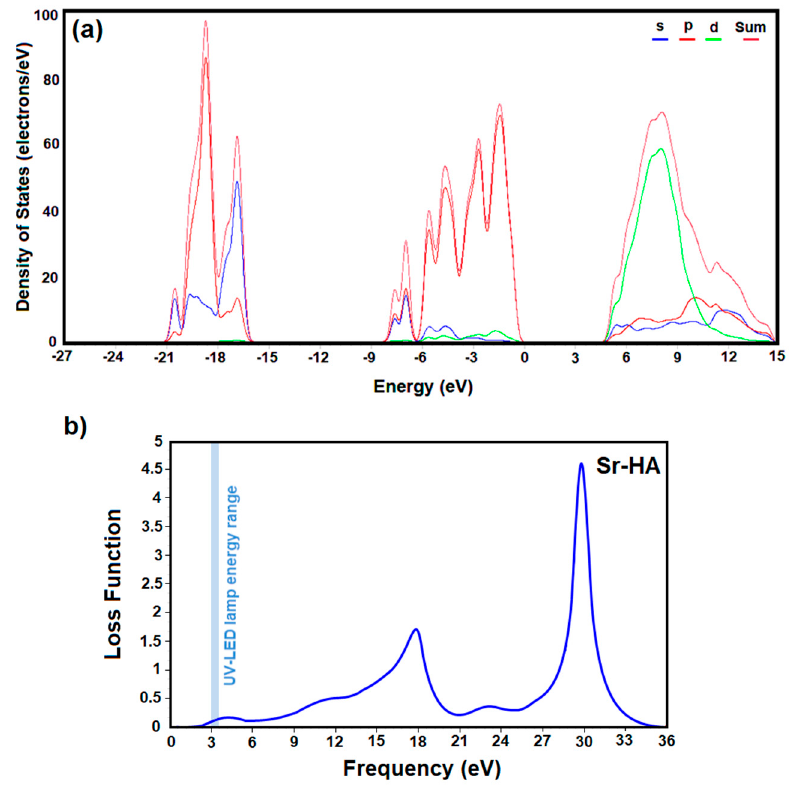
Figure 2. Electronic densities of states ( a ) and energy-loss spectra ( b ) of Sr-doped HA, obtained by DFT calculation.